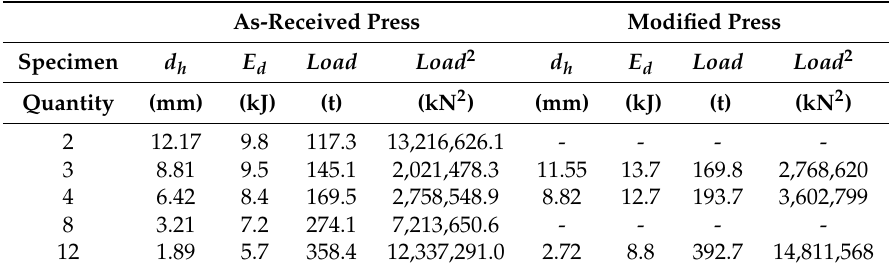
Table 4. Forging loads and energy in different symmetry configurations and specimen quantity of SAE